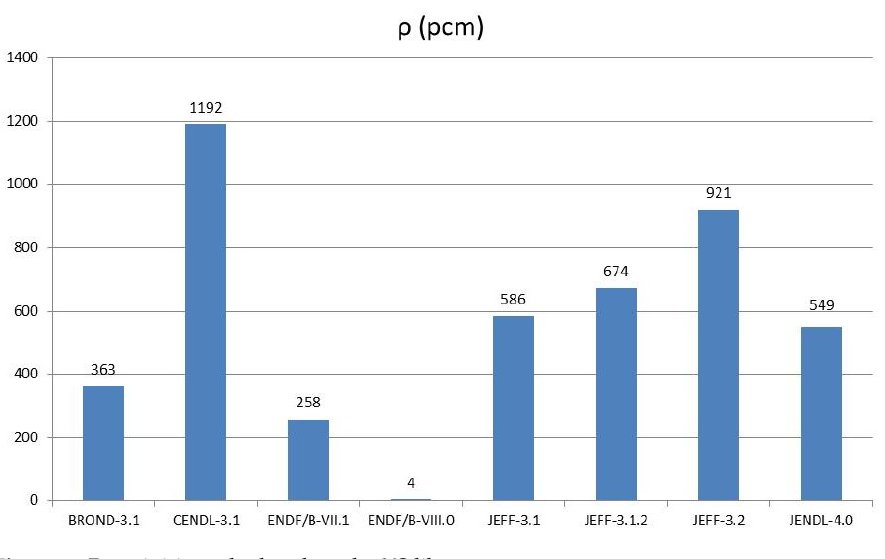
Figure 4. Reactivities calculated on the XS library